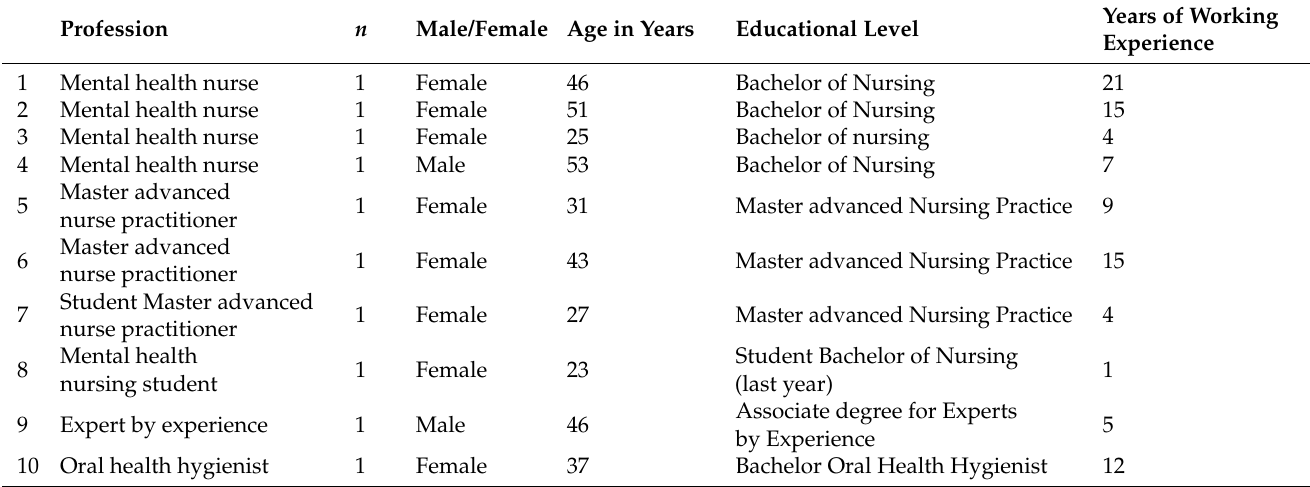
Table A1. Characteristics of Professionals Included in the Contextual Interviews (n =